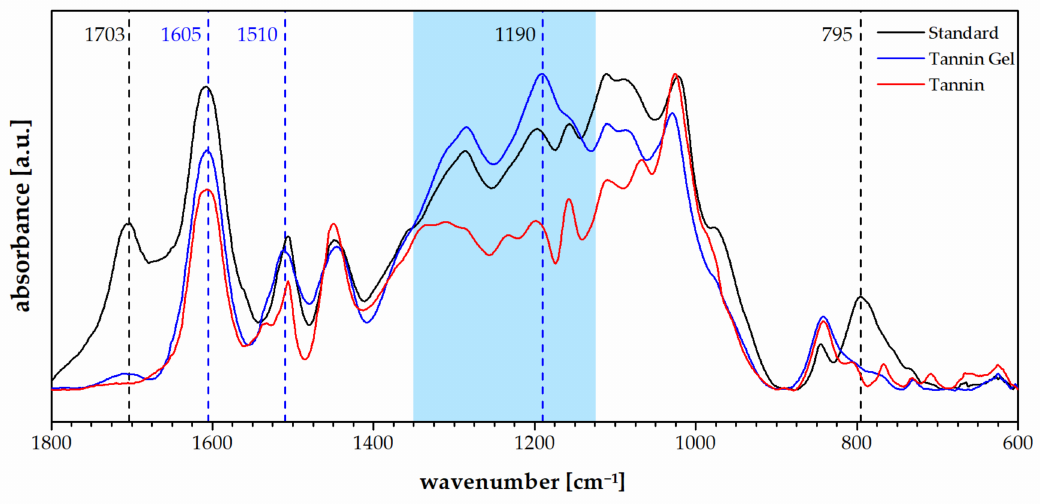
Figure 3. FT-IR spectra of the standard foam (black), the tannin acidified gel (blue), and the tannin extract (red).